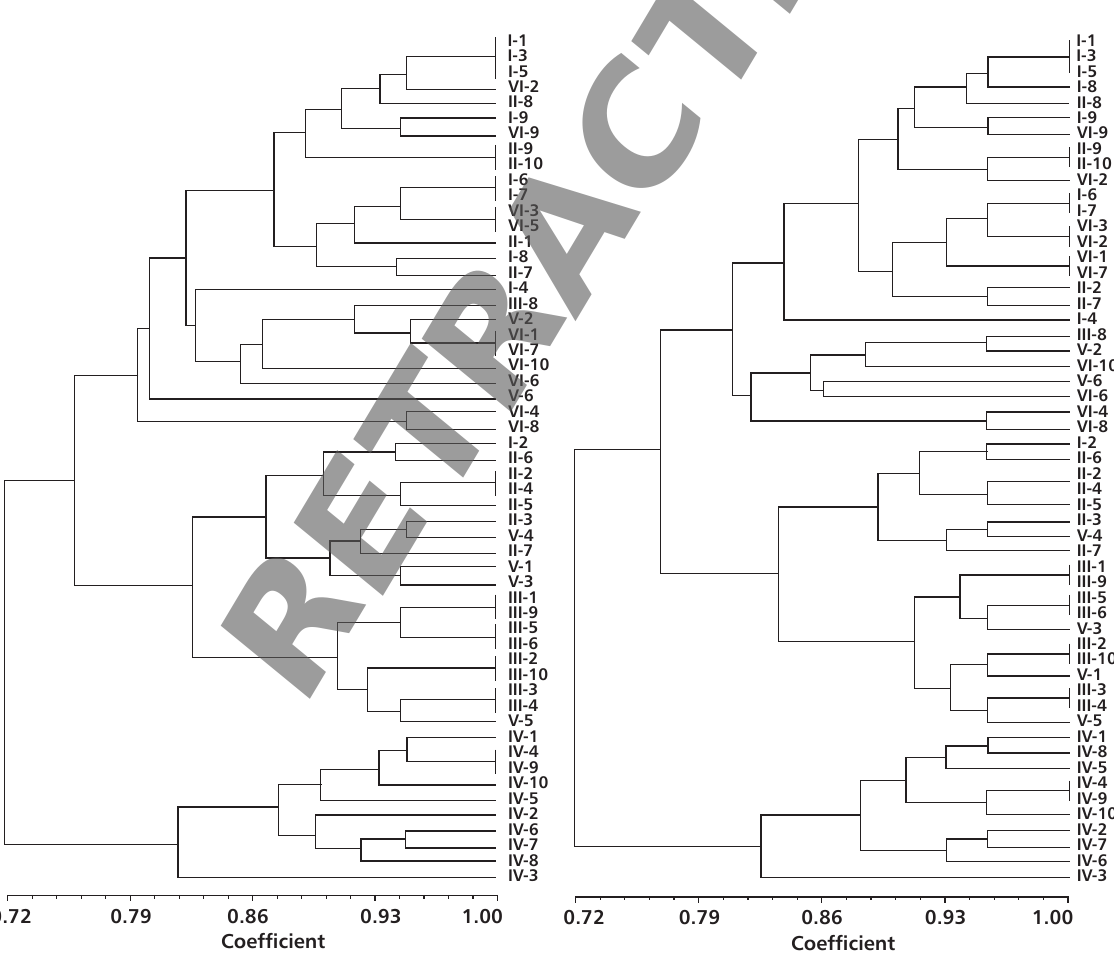
Dendrogram of genotypes of six Austrian pine populations after Sokal and Michener (a) and after Jaccard